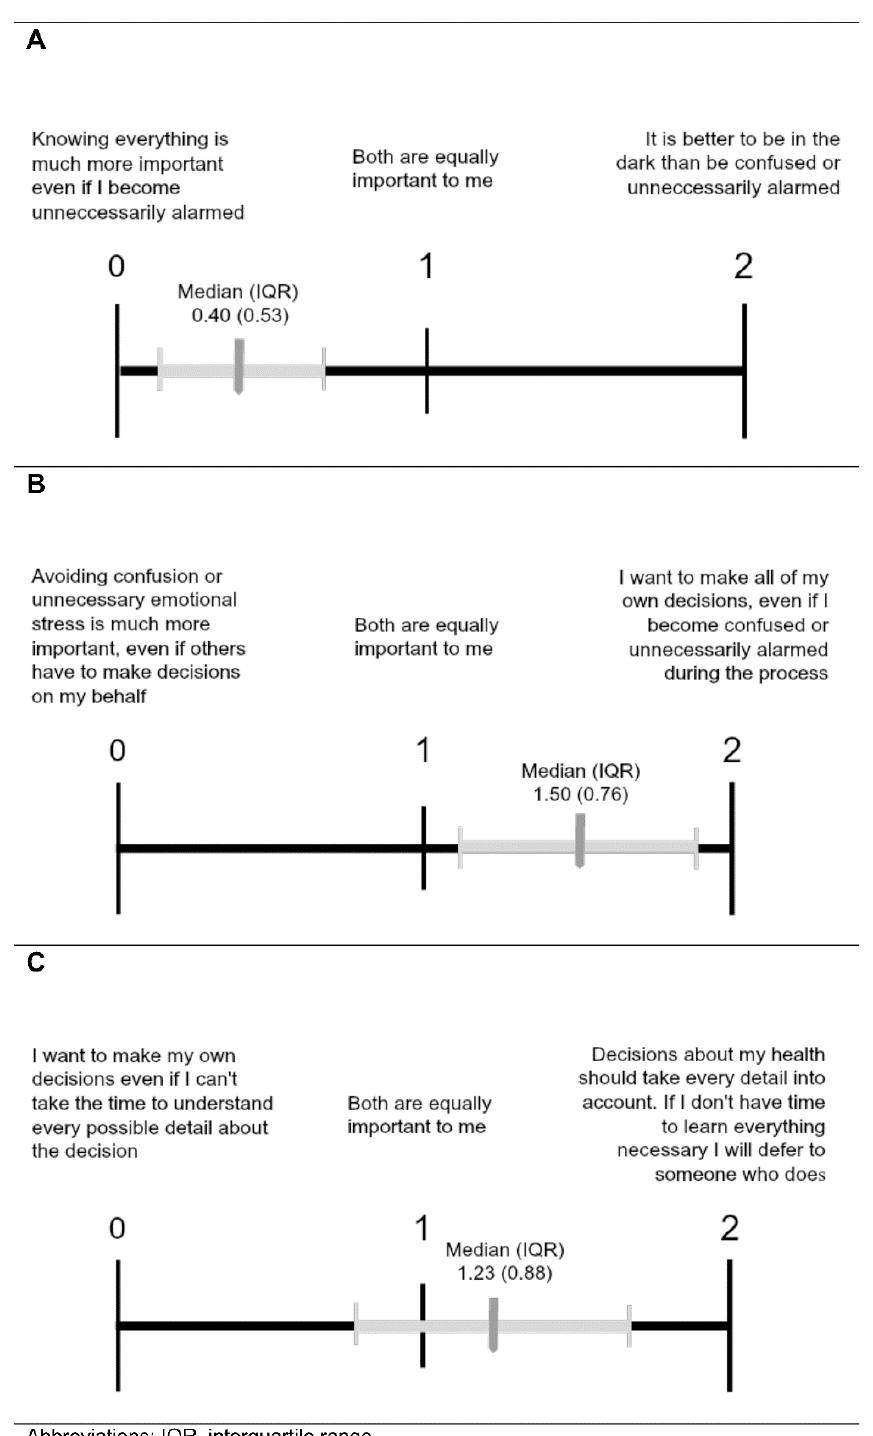
Figure 5. Comparisons of values associated with Fully Informed ( A ), Parents Decide ( B ), and Withholding policies ( C ). Results from parents given value comparison questions to express their views about the importance of the three policy options that may be associated with stress. Values are as described in Figure